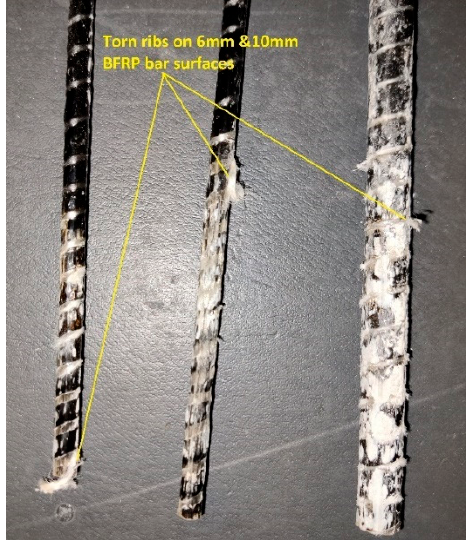
Figure 14 . Wear and tear on rib fibres on the pulled-out bar surface.